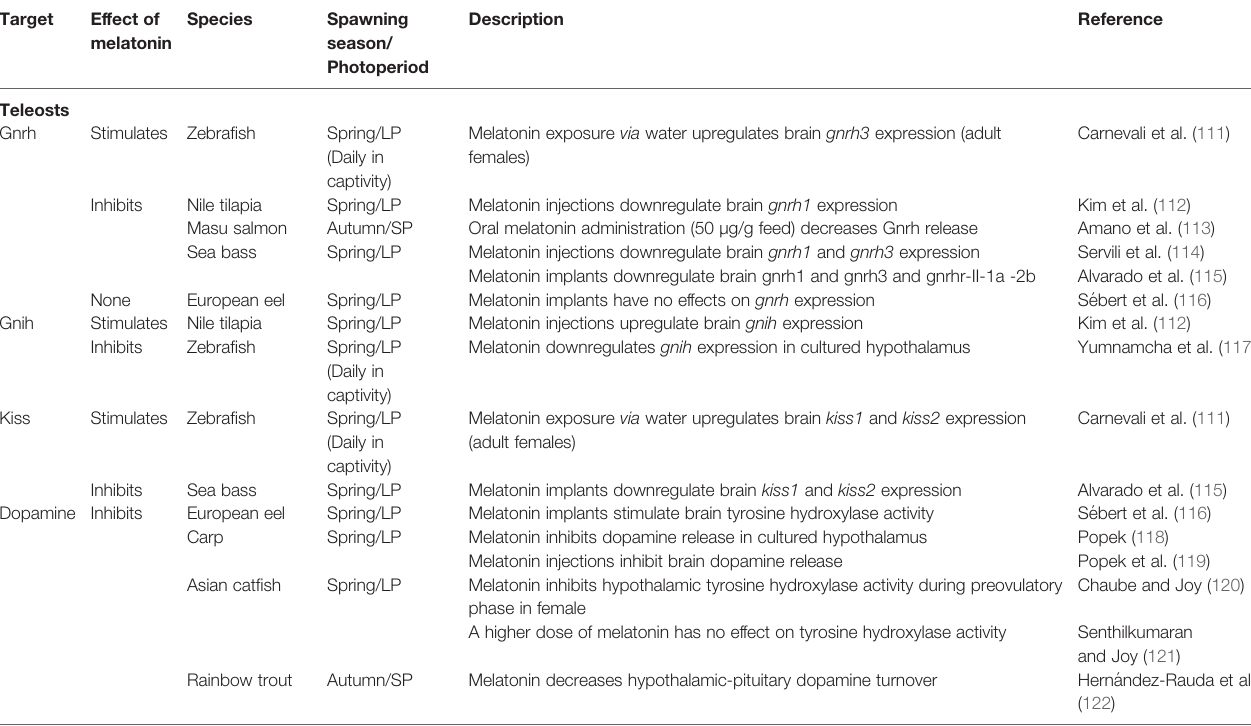
TABLE 2 | Summary of the known effects of melatonin POA/hypothalamic neurons controlling pituitary hormonal production in teleosts. Target